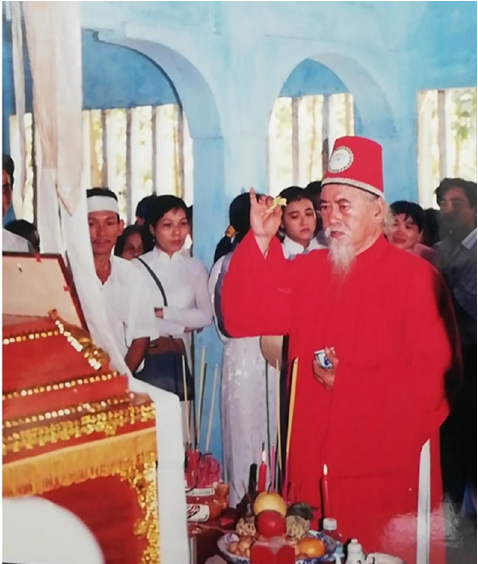
Figure 9. The talismanic ritual of Hành phép xác performed at the crematorium by the priest of Bình Hòa temple, B ế n Tre branch, Hochiminh City, March 2001 (© Jérémy Jammes). H ò a temple, B ế n Tre branch, Hochiminh City, March 2001 ( © J é r é my